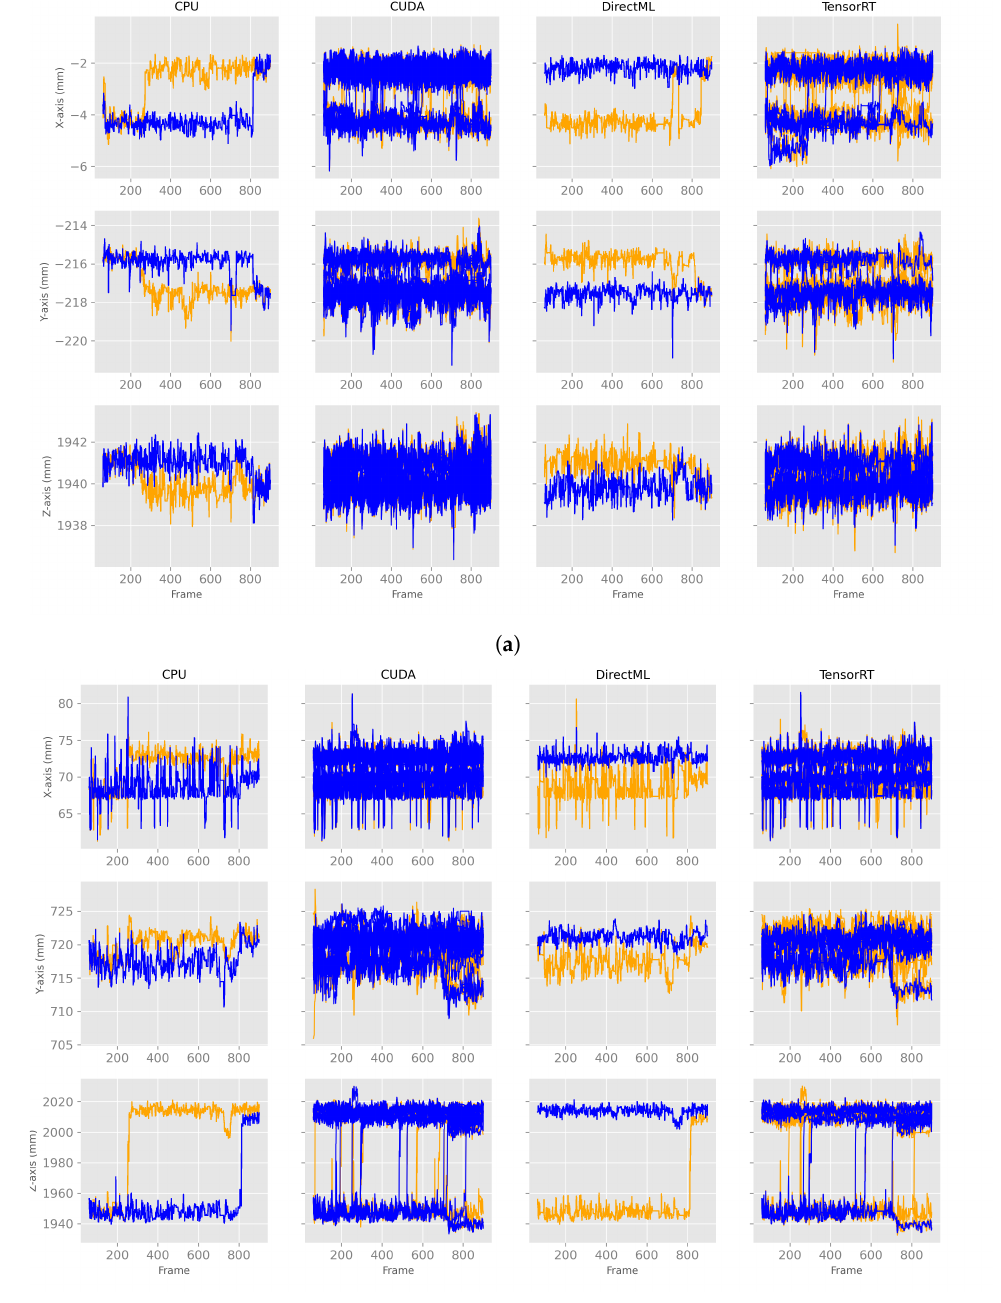
Figure A2. X -, y -, and z -axes of the joint positions of PELVIS and FOOT_LEFT for all four processing modes for two different computers. The blue lines are from computer A and the orange from computer B. ( a ) X -, y -, z -axes for the joint position of PELVIS. ( b ) X -, y -, z -axes for the joint position of